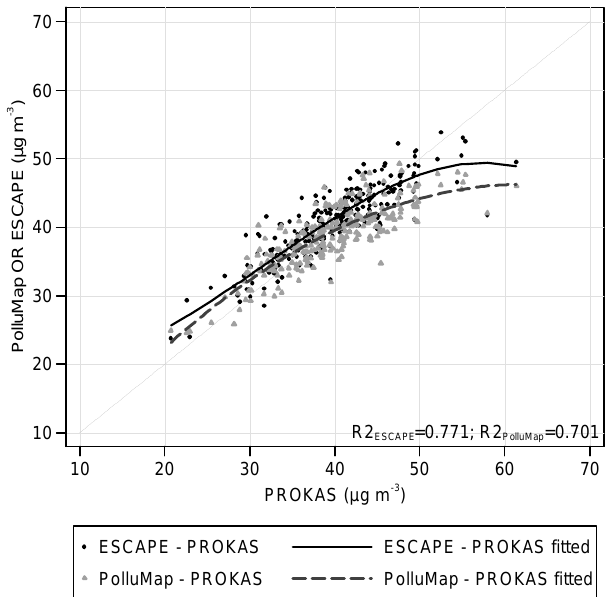
exposure of subjects 2